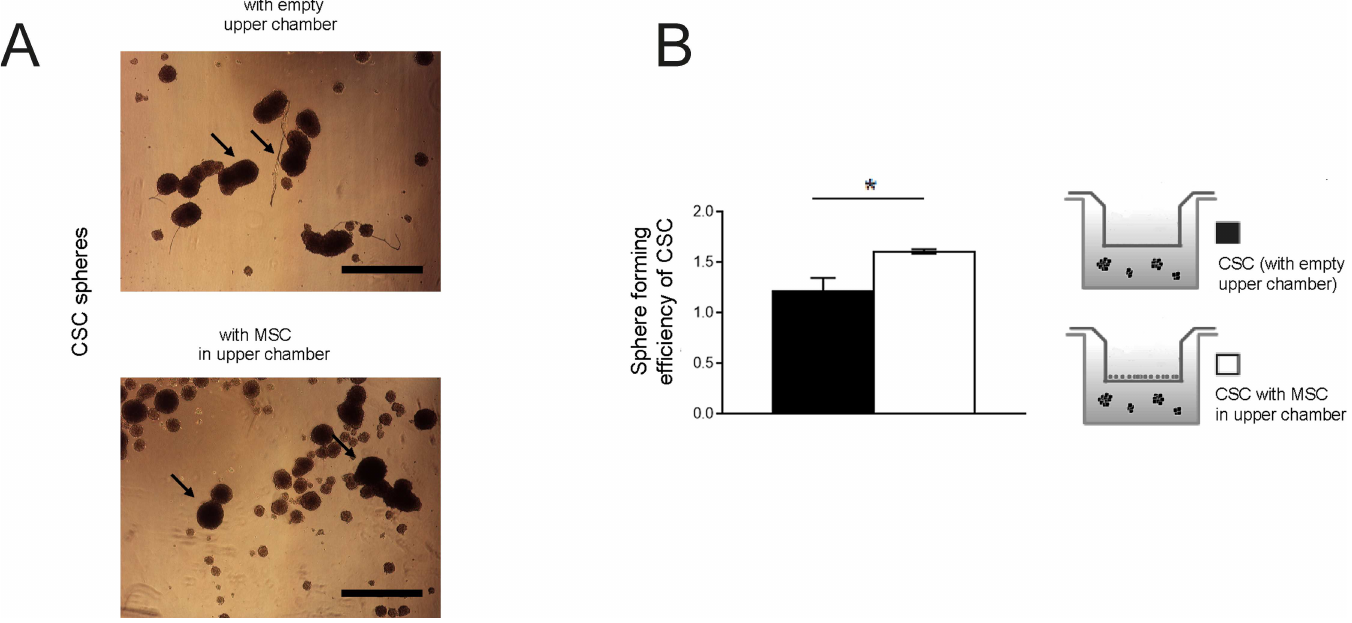
Fig 3. MG63 OS cells form spheres and their number is increased by the presenceof MSC. (A) Homotypiccultures of CSC and their co-culture with MSC for 6 days were photographed at a magnification of 4x, representative images (scale bar 500 μ m, black arrows show the spheres with highersize); (B) sphereswere counted and expressed as sphere forming efficiency (number of spheresformed / number of cells seeded × 100) ( * p < 0.05).